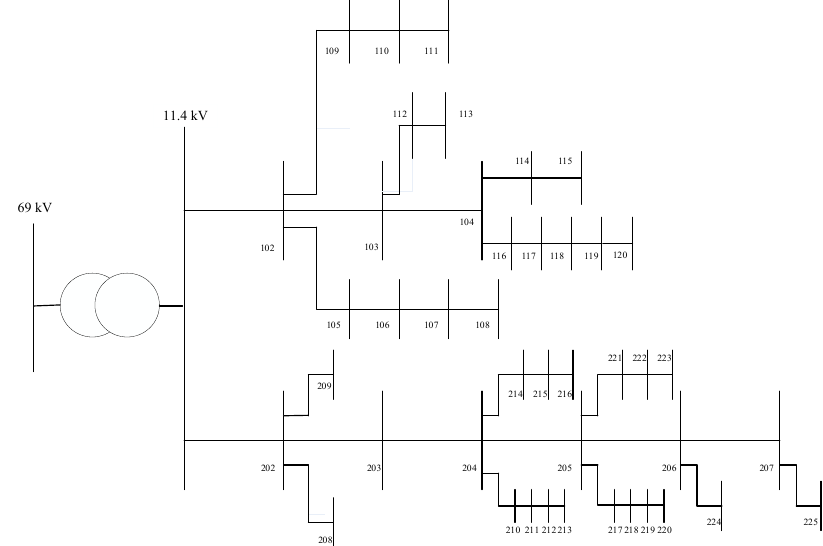
Figure 6. A substation system including two feeders.